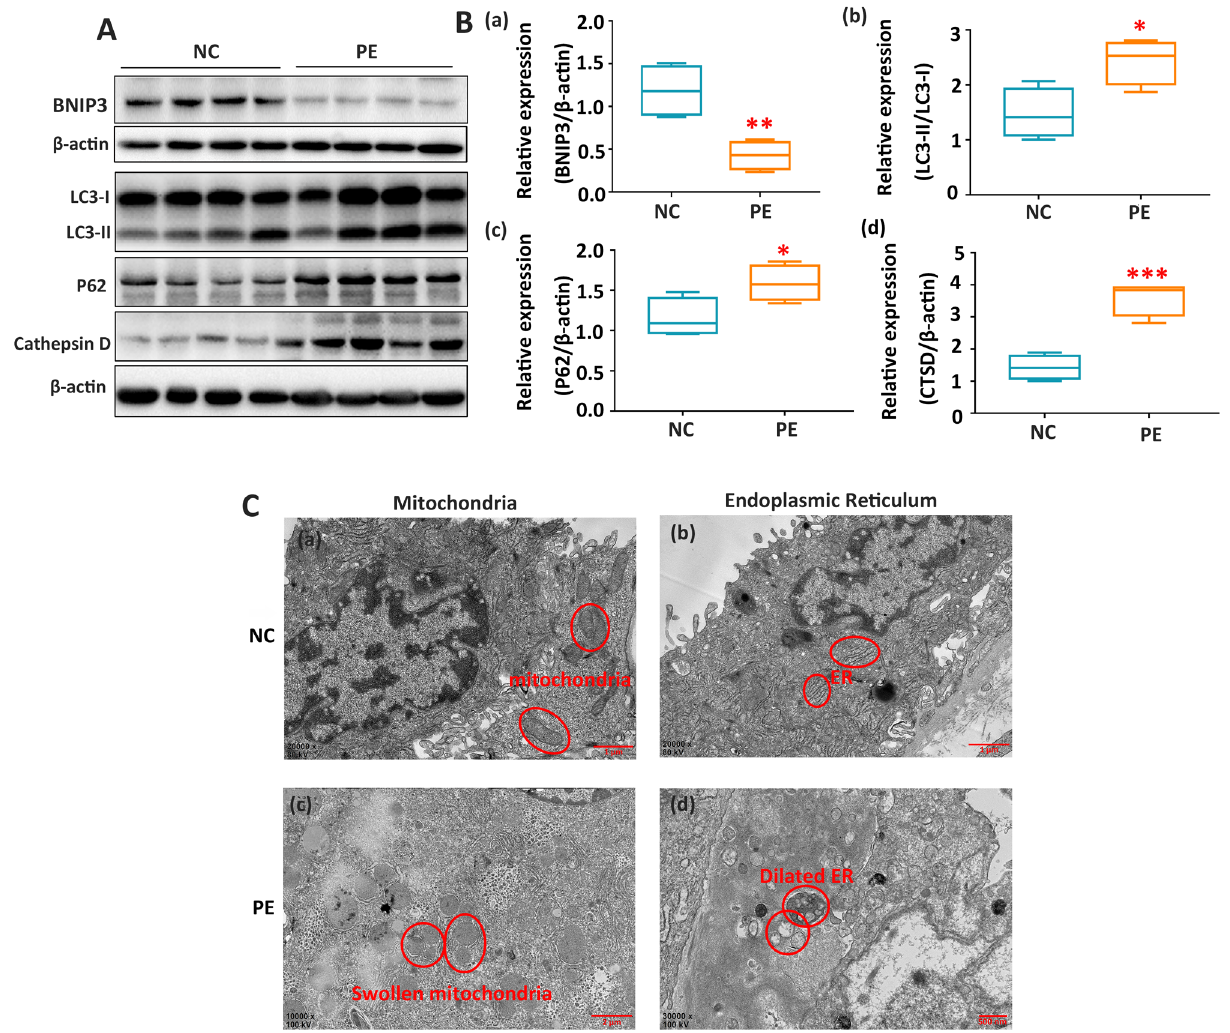
Figure 1. Suppression of BNIP3 with impaired autophagy and increased level of damaged mitochondria in vivo. ( A , B ) Western blotting: the proteins in the PE placental tissue that were associated with dysregulation of autophagy were BNIP3, LC3-II, P62, and CTSD for PE (n = 16) and normal pregnancies (n = 18). β-Actin was used as a control * p -value < 0.05, ** p -value < 0.01, *** p -value < 0.001. ( C ) Electron micrograph showed the different morphologies of mitochondria and endoplasmic reticulum (indicated by circles) of the placental trophoblast cells from placentae of normal (n = 4) and preeclamptic pregnancies (n = 4). Full-length blots are presented in Supplementary Figure